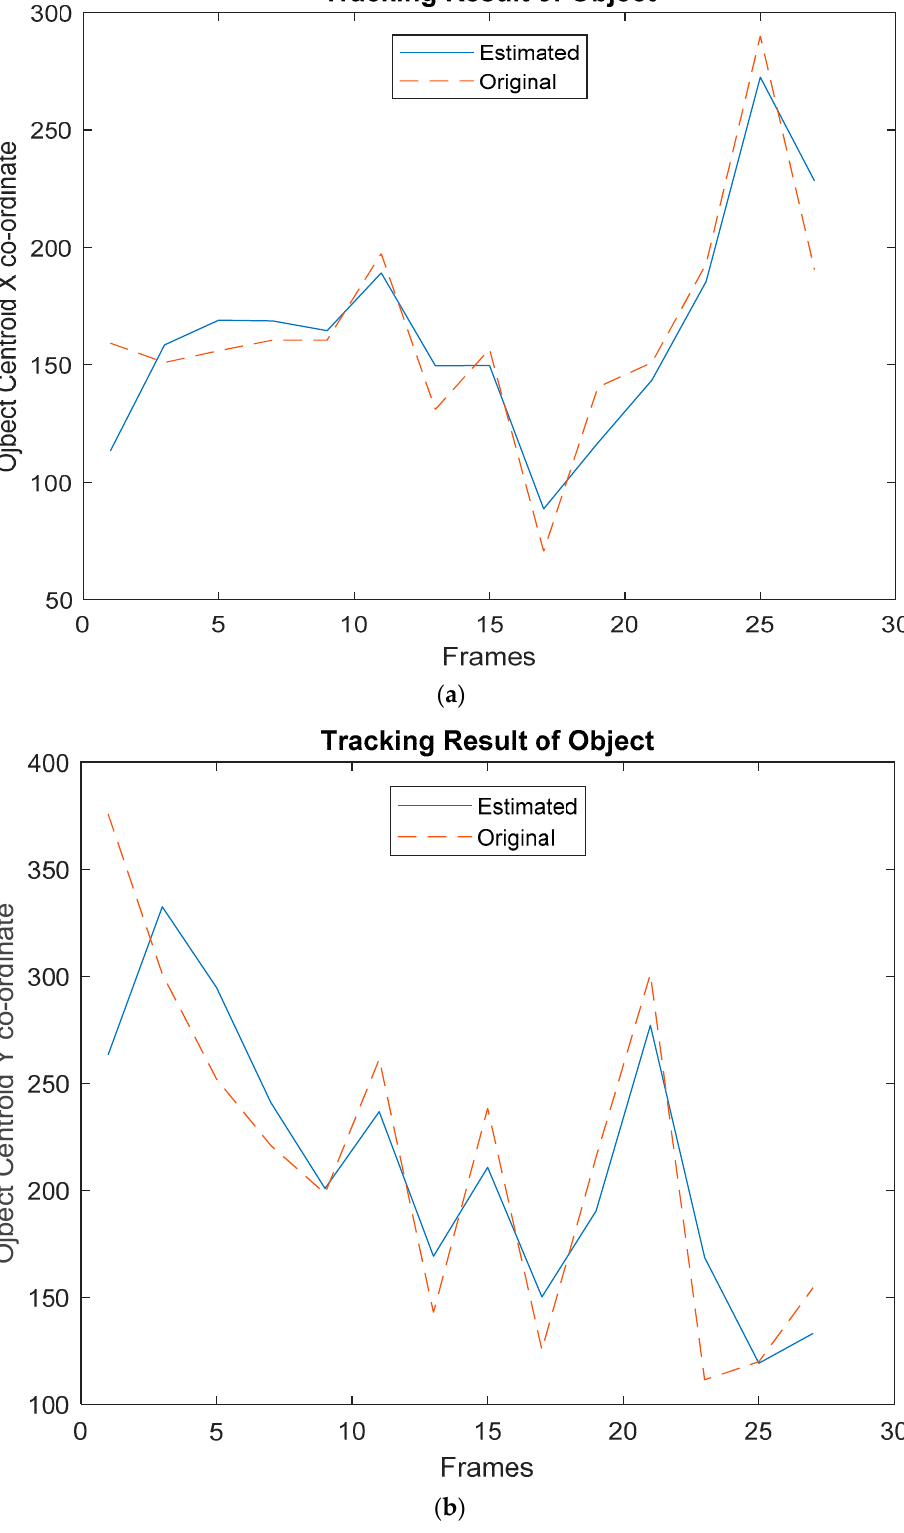
Figure 21. Tracking result of object centroid X and Y coordinates ( a ) X co-ordinate Tracking ( b ) Y co-ordinate Tracking.